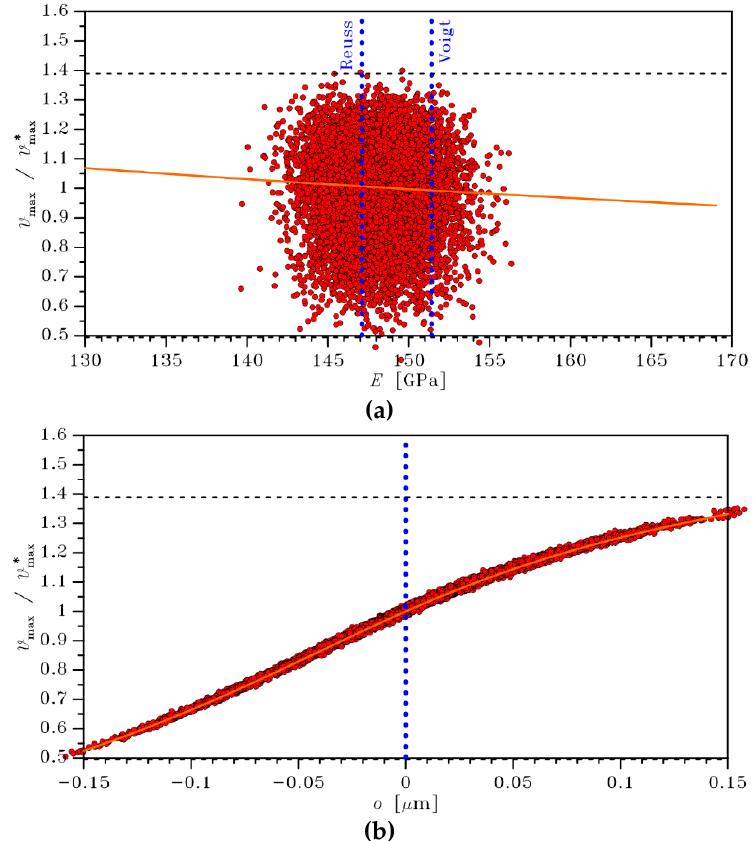
Figure 7. Monte Carlo simulation, h = 2 µ m: scattering in the value of V max , and comparison with the trends induced by ( a ) E and ( b ) o alone.